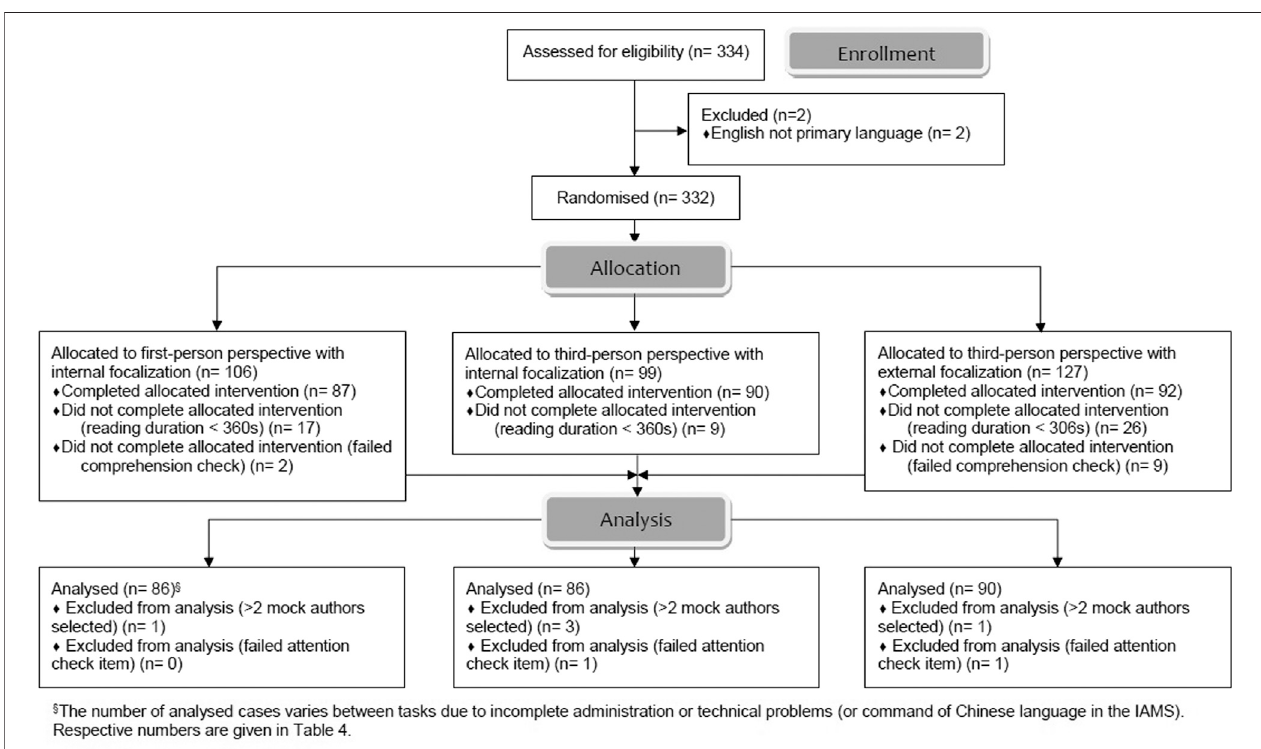
FIGURE 4 | Flow of participants through Experiment 2.